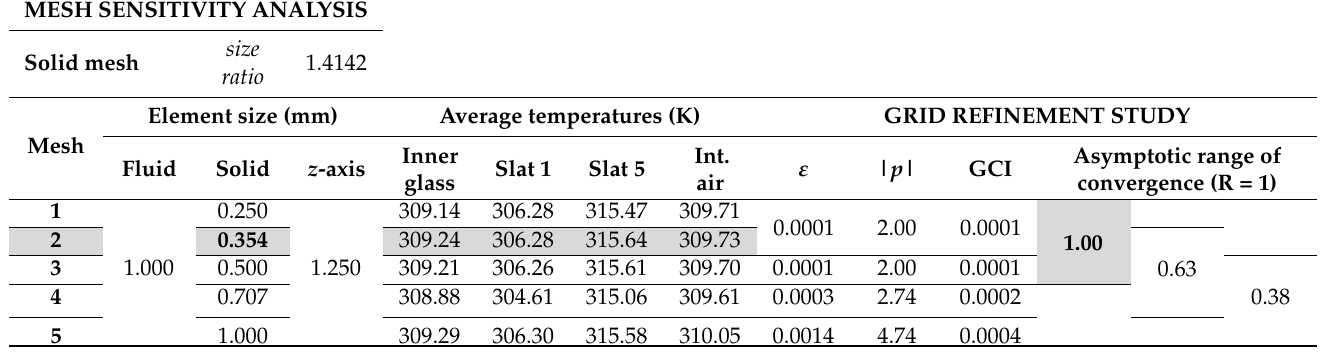
Table 6. Results of the grid refinement